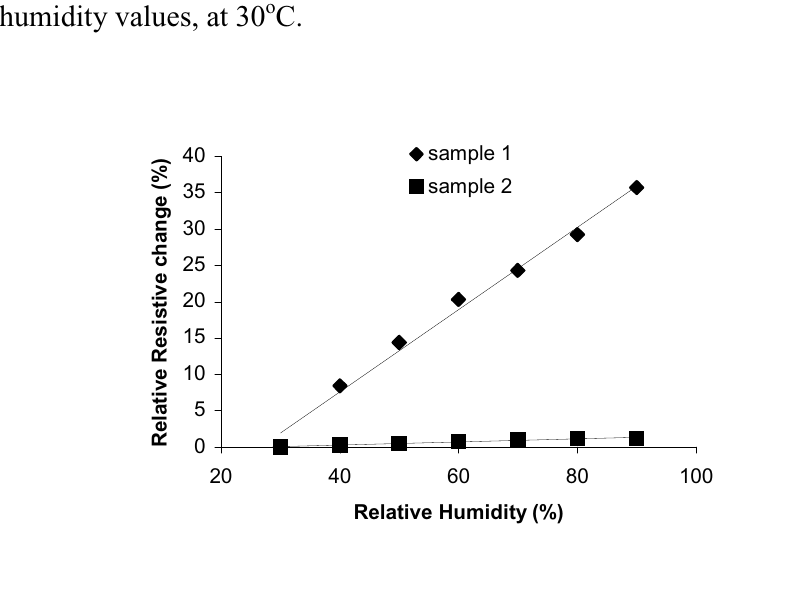
Figure 5. Variation in relative resistance ∆ R of the samples as a function of the increasing relative humidity values, at 60 o